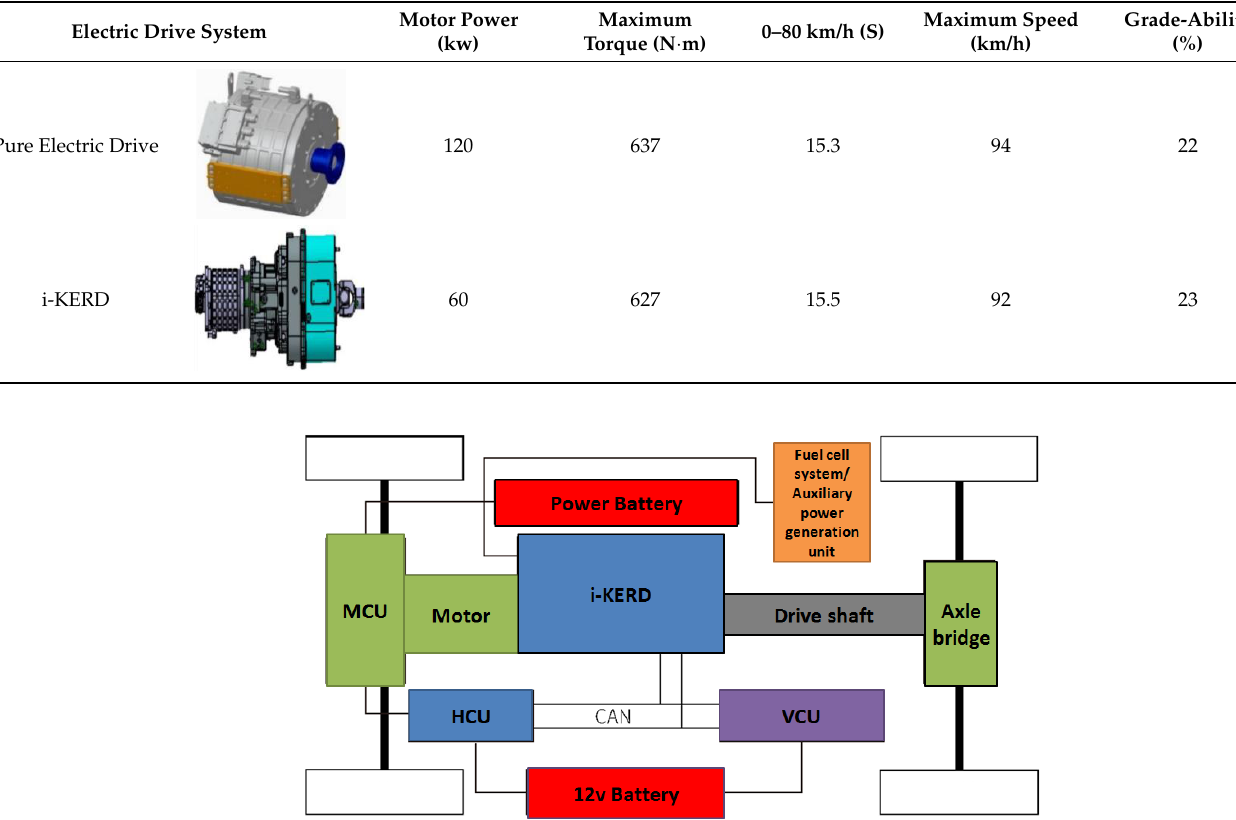
Table 2. Comparison of Electric Drive System Configurations.